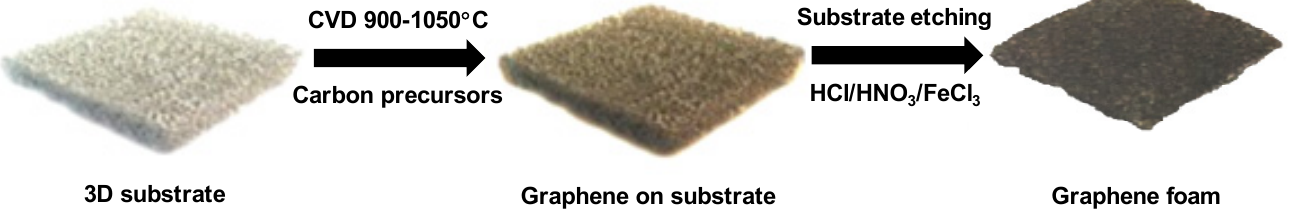
Scheme 1. Schematic - presentation of the synthesis of 3D graphene networks by CVD.